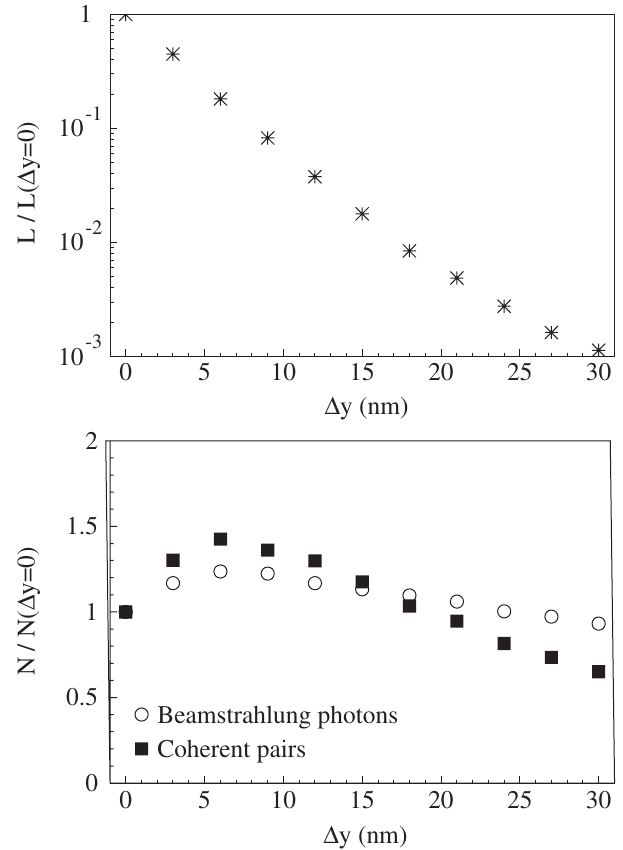
FIG. 25. Influence of a vertical position beam-beam offset on the luminosity (top) and on the amount of beamstrahlung pho- tons and coherent pairs